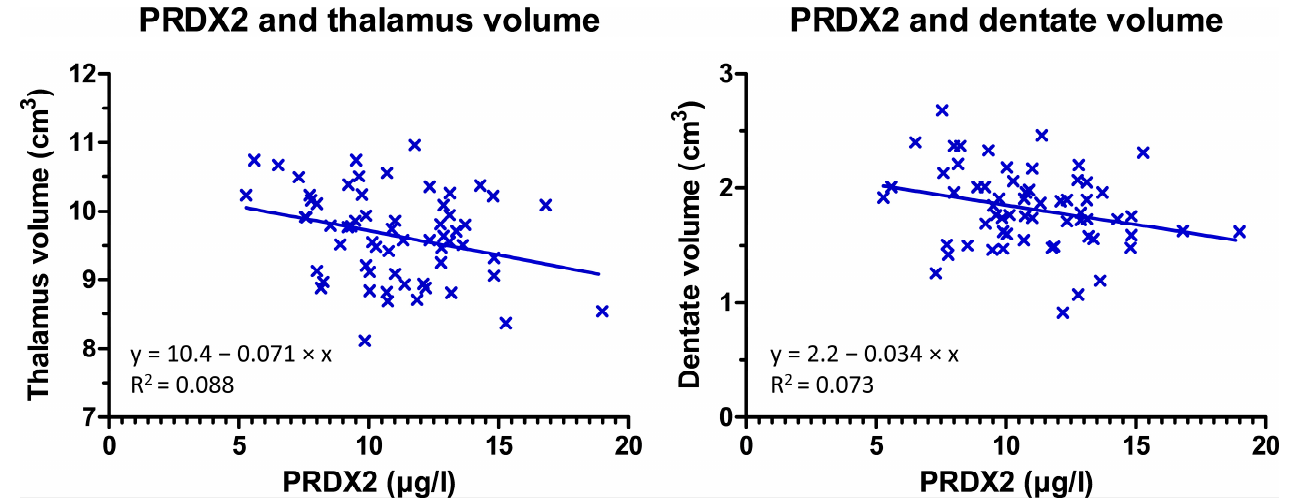
Figure 2. Scatter plot and regression line show negative correlation between PRDX2 and volume of the thalamus ( left ) and the dentate nucleus ( right ).